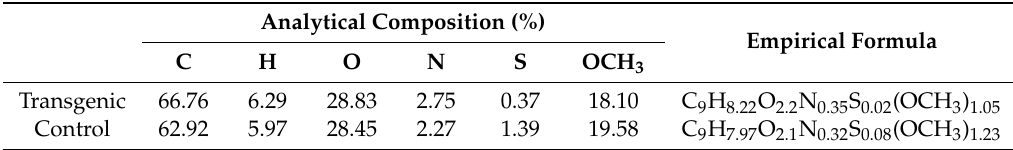
Table 3. Chemical composition of switchgrass